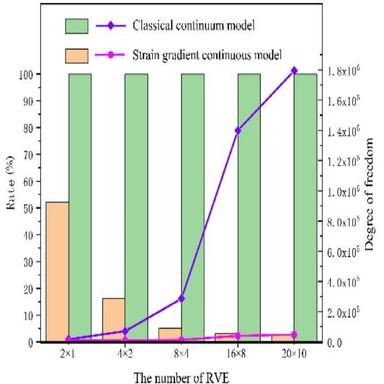
Two methods are used to calculate the variation trend of degrees of freedom.